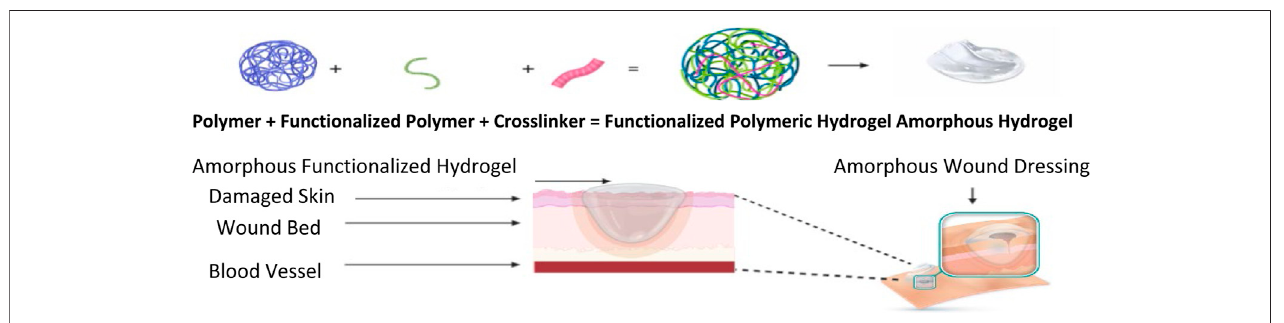
FIGURE 3 | Synthesis and application of functionalized amorphous